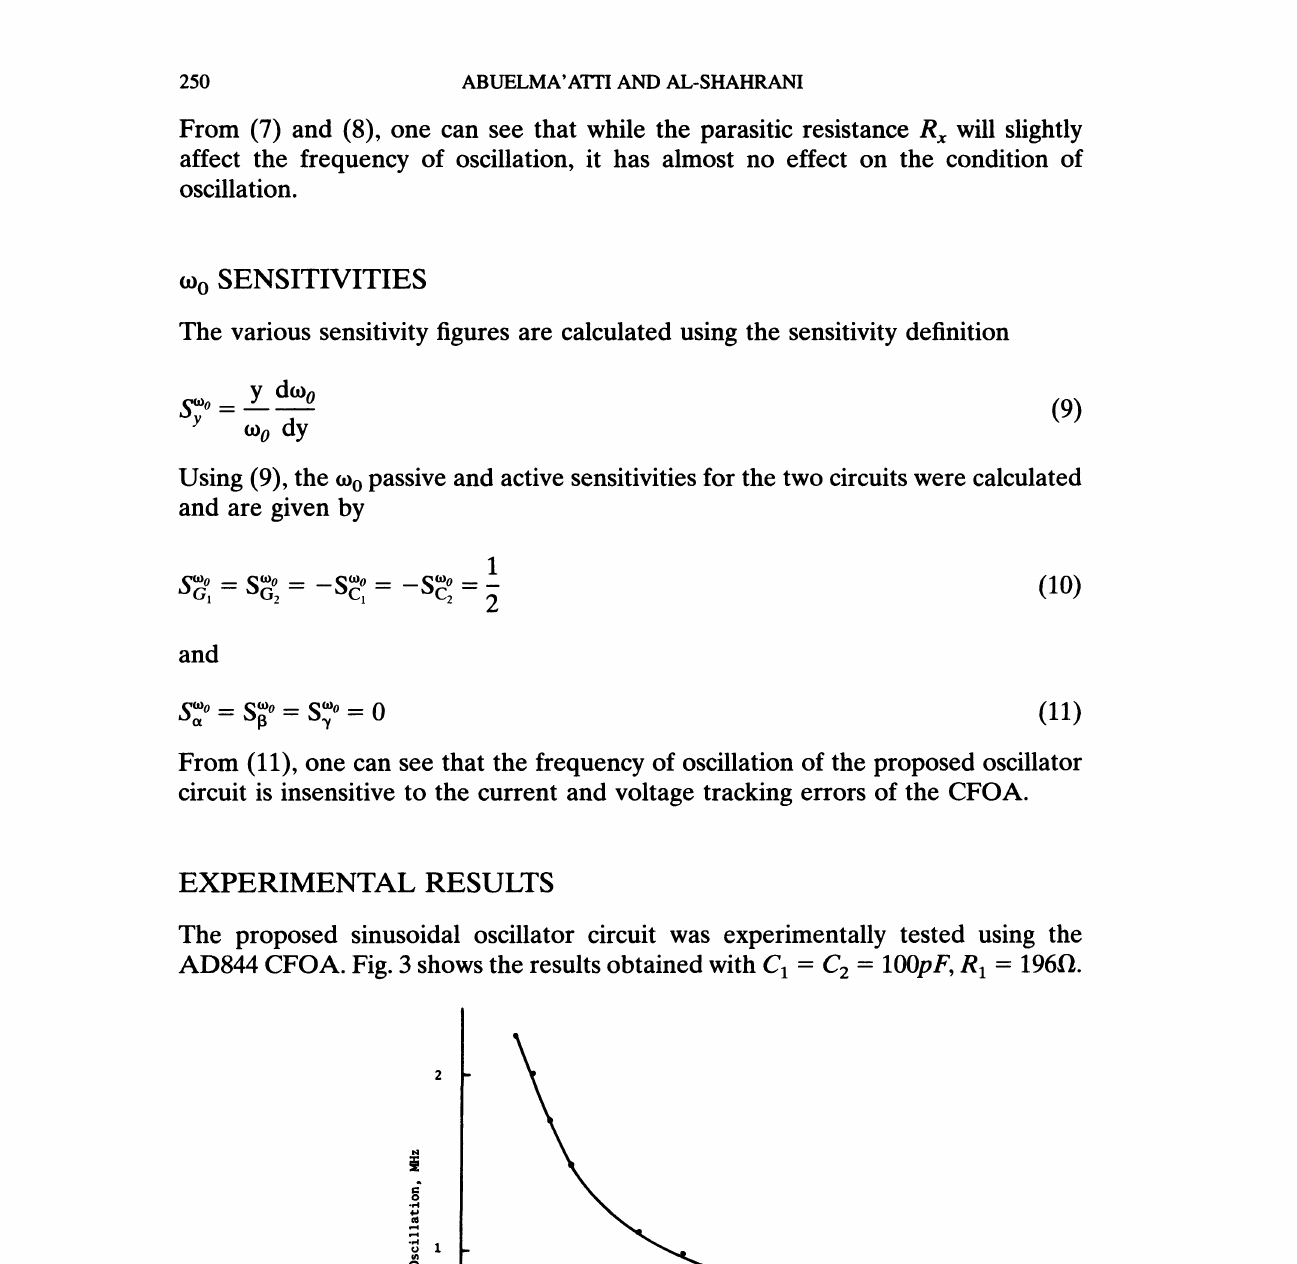
FIGURE 3 Measured Frequency of Oscillation with